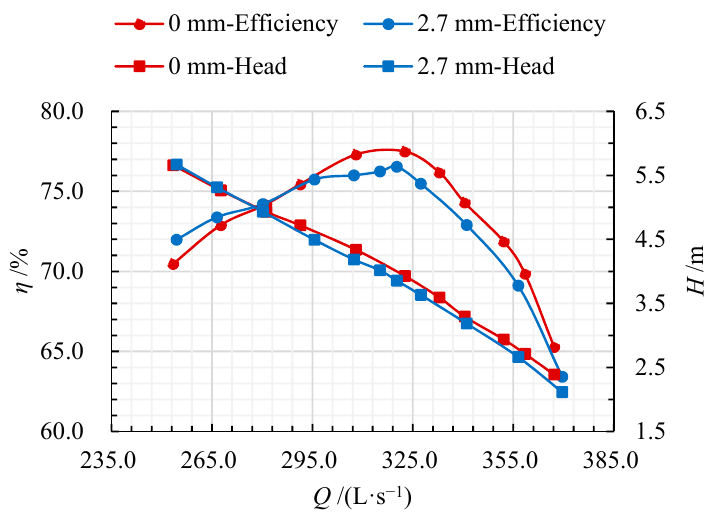
Figure 5. Comparison of simulated pump performance under different root clearance radii.